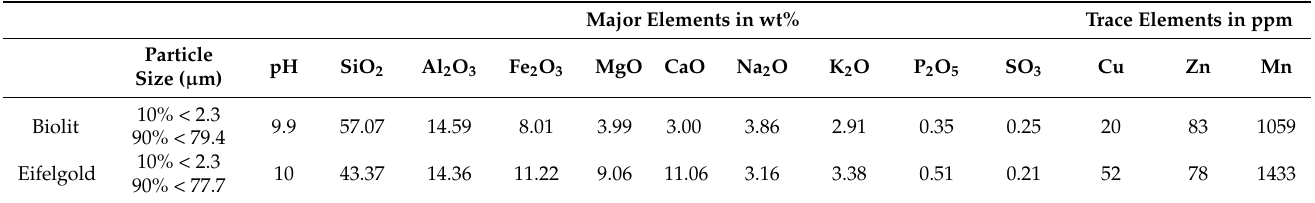
Major Elements in wt% Trace Elements in ppm